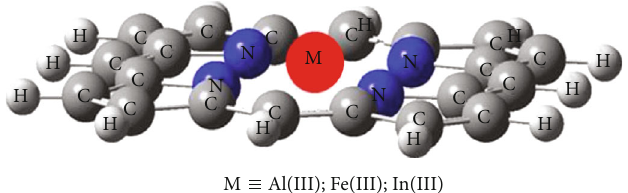
Figure 1: Chemical structure of the metalloporphyrin complexes.